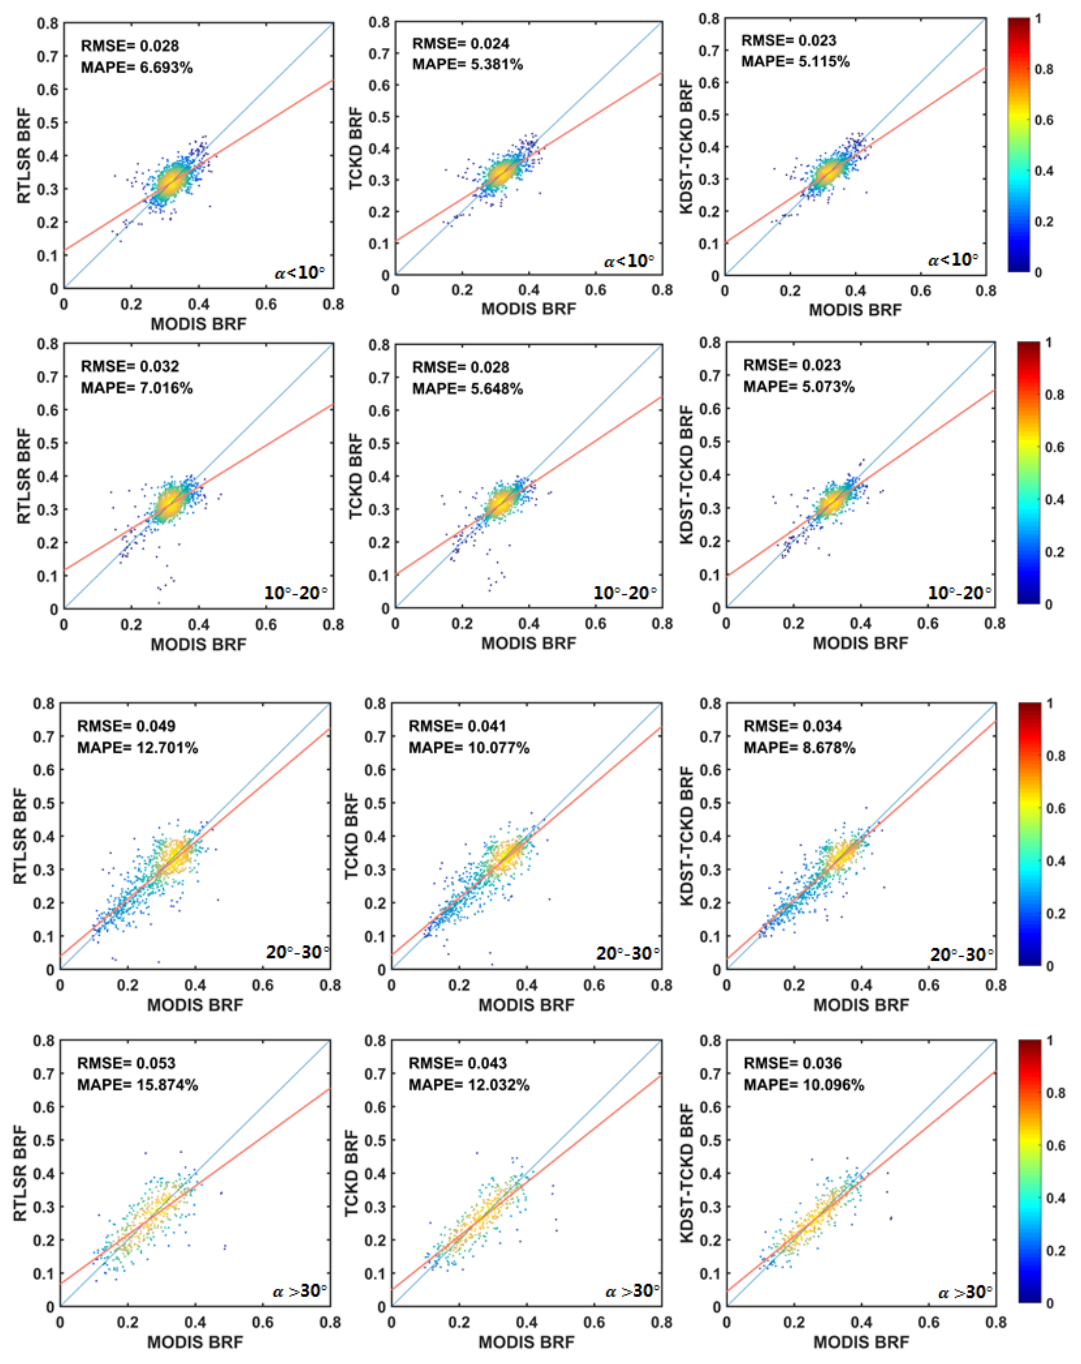
Figure 10. Comparison of the NIR BRF retrieved by the RTLSR, TCKD, and KDST − TCKD models with MODIS BRFs under different terrains (all land types are included). The orange lines are the lines of best fit. The colors correspond to the point density from the lowest (blue) to highest (yellow). From the first row to the fourth row are different mean slopes, and columns from left to right are the RTLSR, TCKD, and KDST − TCKD models.